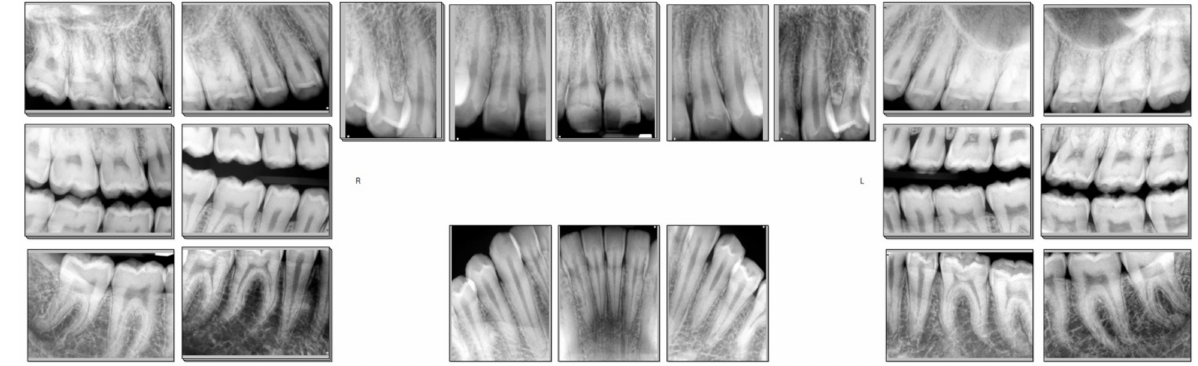
Figure 4. Pretreatment full-mouth X-rays. Interproximal caries is visible on multiple posterior teeth.